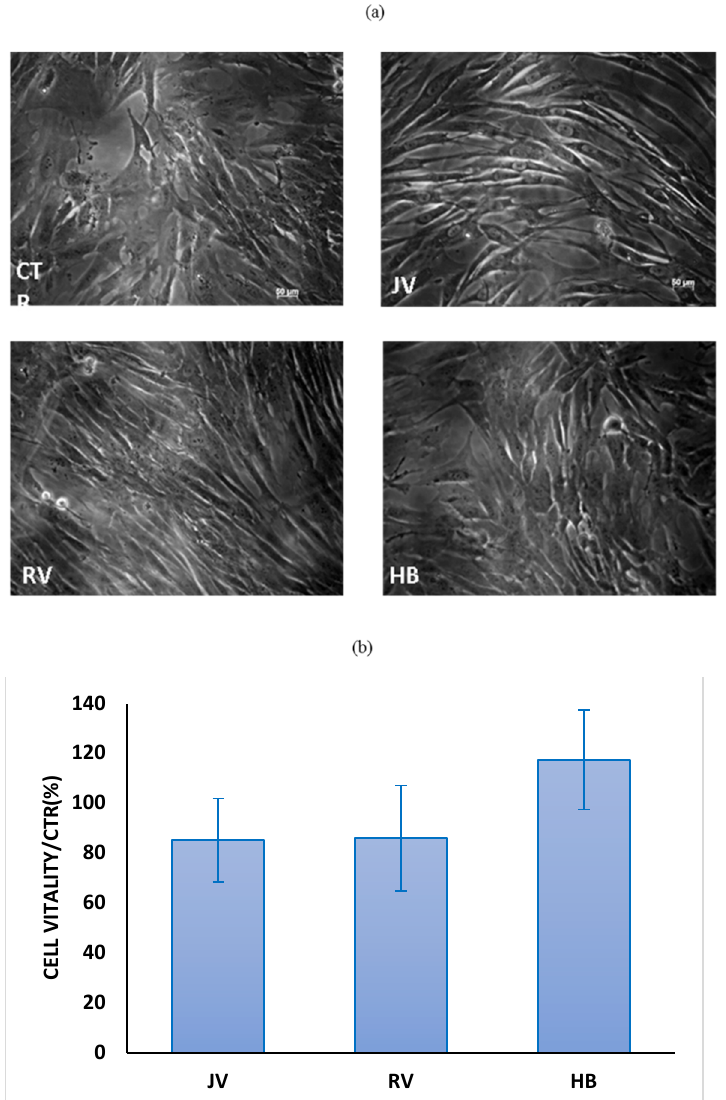
Figure 6. ( a ) Morphological observation at MO of Human Dermal Fibroblasts (HDF) in the control and in presence of filler, after 24 h treatment. Scale bar 50 µ m; ( b ) Cell vitality with respect to the untreated cells in presence of J V , R V and H B respectively.